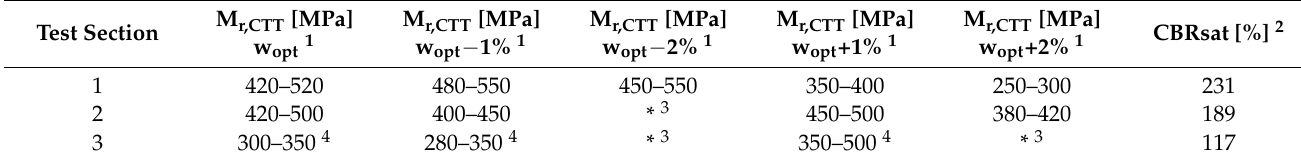
Table 3. Average M r,CTT values and approximate values of CBR for base layers of the monitored road sections.